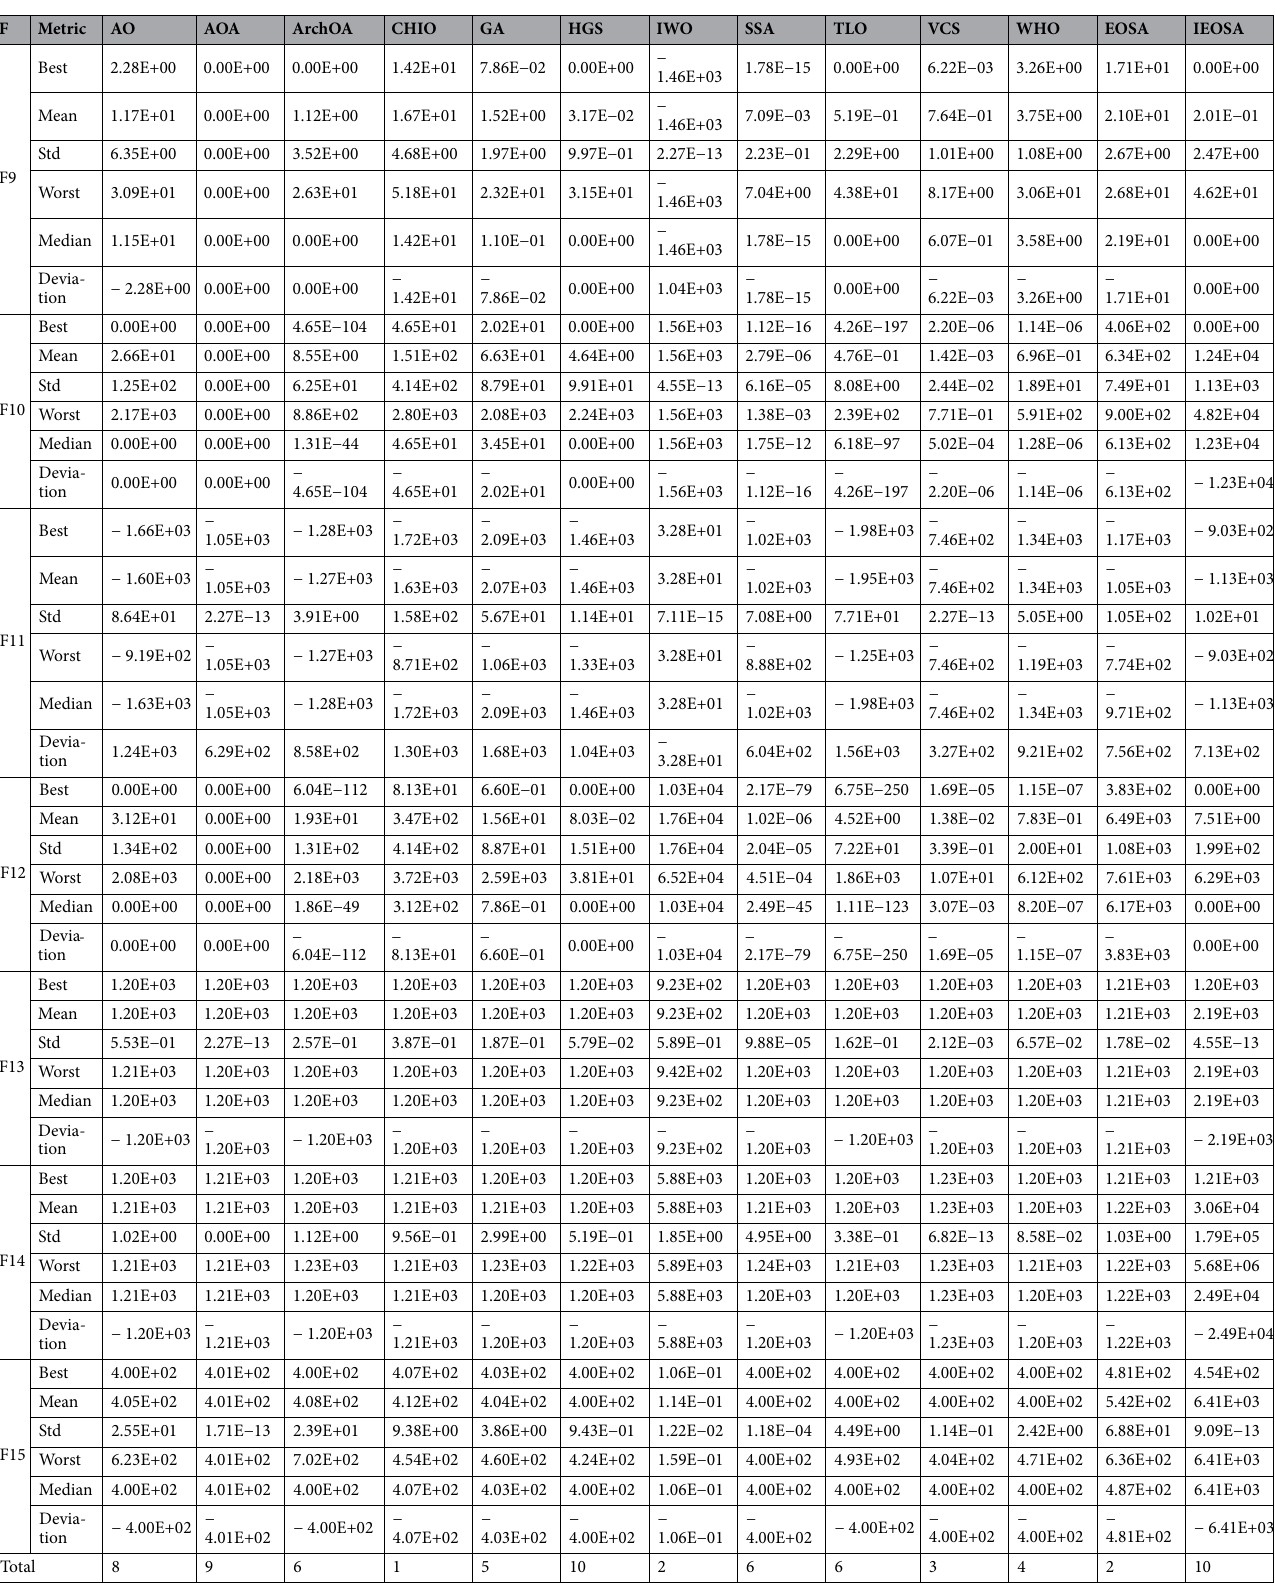
Table 4. comparison of the performance of AO, AOA, ArchOA, CHIO, GA, HGS, IWO, SSA, TLO, VCS, WHO, EOSA, and IEOSA using fifteen (15) benchmark